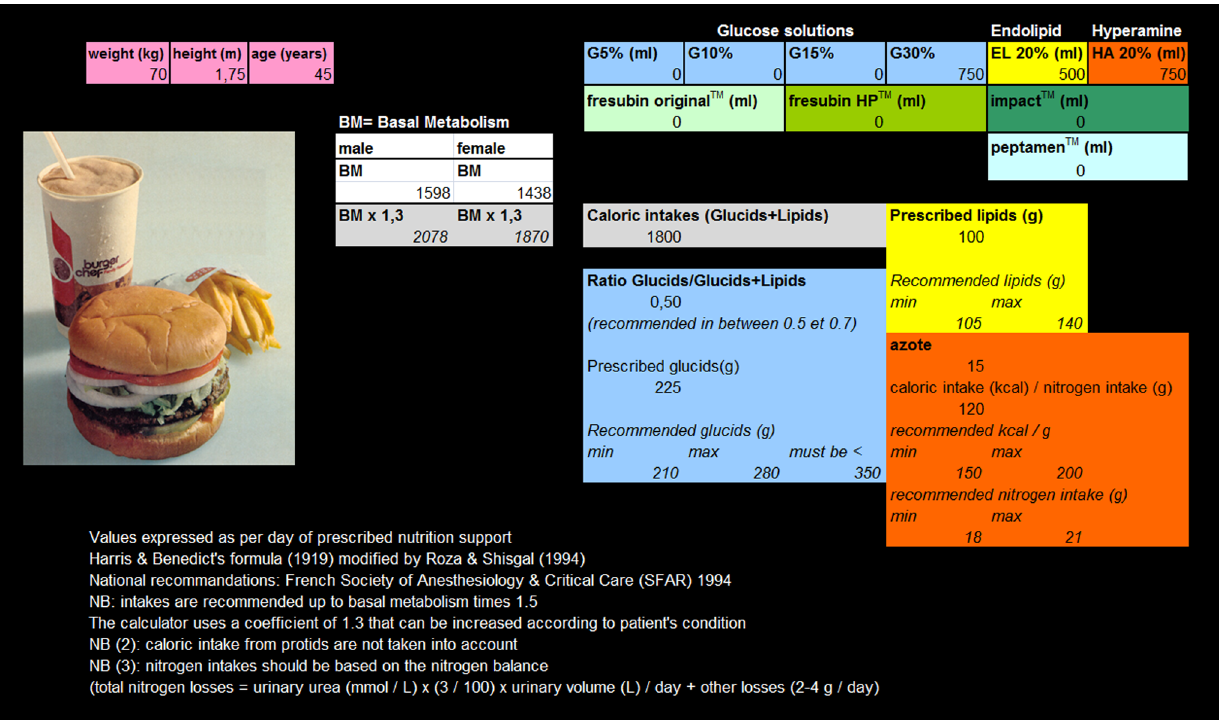
Figure 1. Screenshot of the Excel spreadsheet ‘‘computer-assisted prescription aid for nutrition. ’’ This computer help is provided in electronic supplement (File S1).